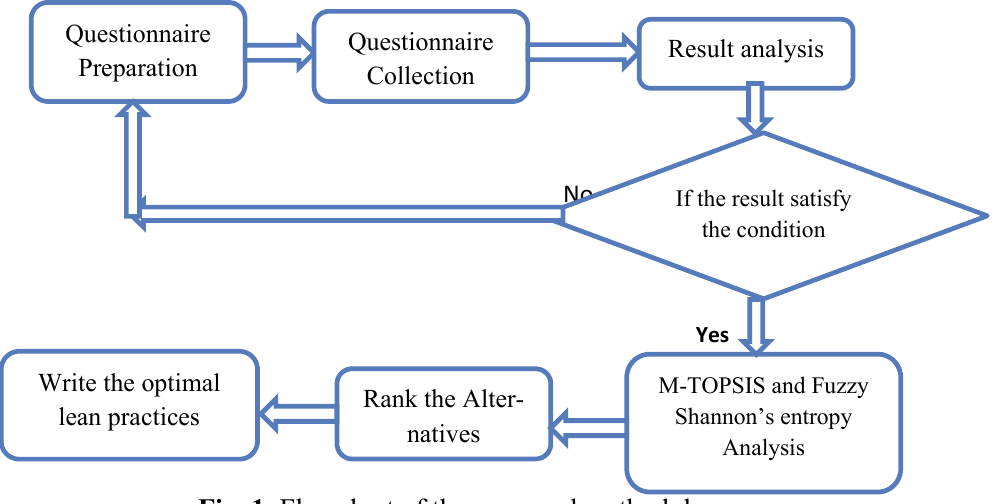
Fig. 1. Flowchart of the proposed